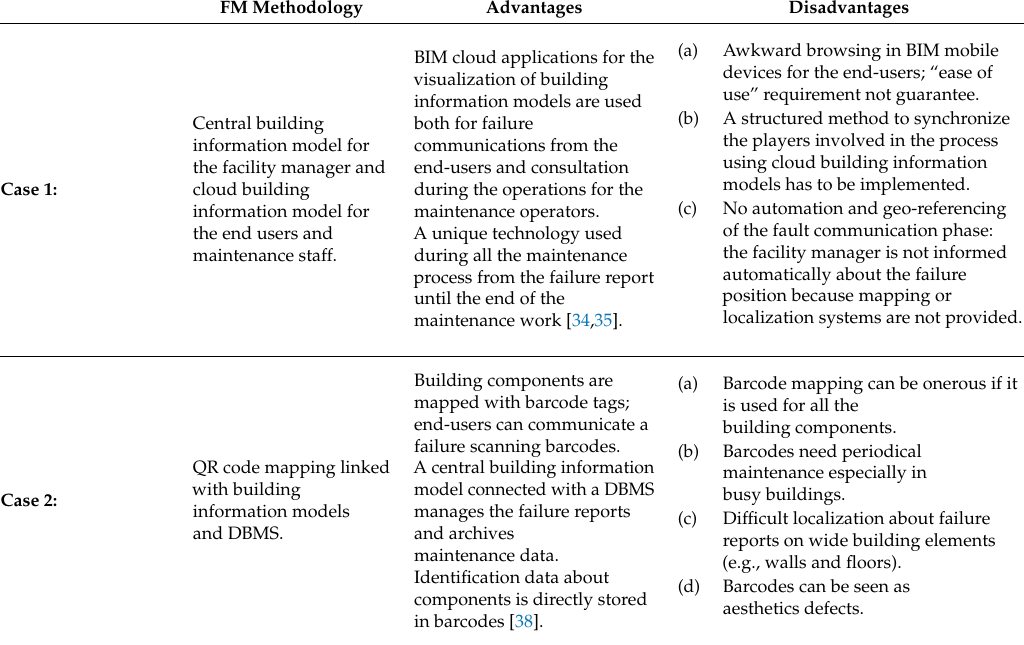
Table 1. Resuming comparison between facility management (FM) supporting